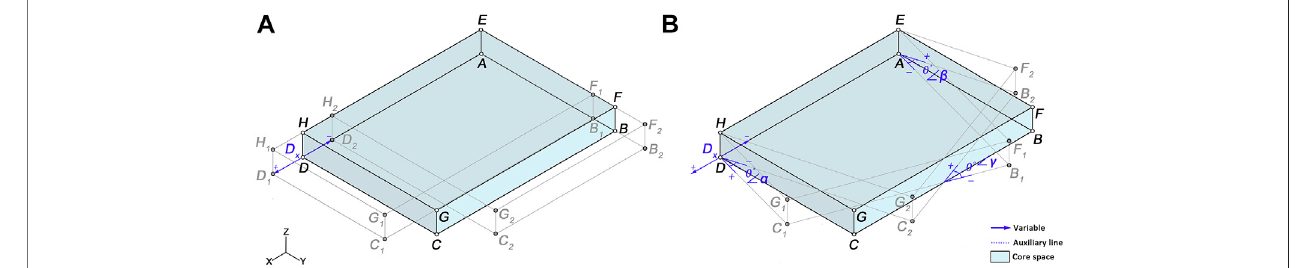
FIGURE 7 | Control nodes and variables of the core space: (A) rectangular plane; (B) convex quadrilateral